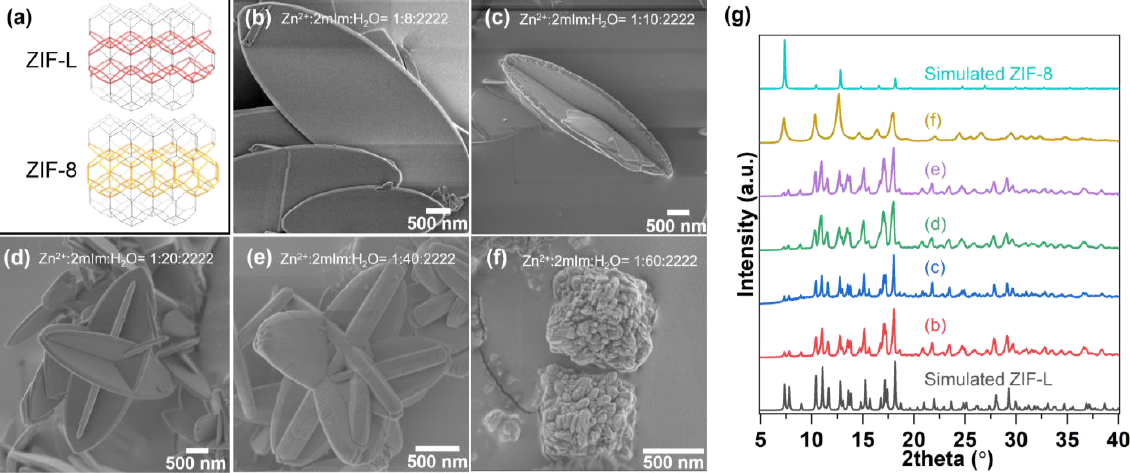
Figure 1. ( a ) Crystal structure of ZIF-L and ZIF-8, SEM images of ZIF-L varying linker ratio ( b )